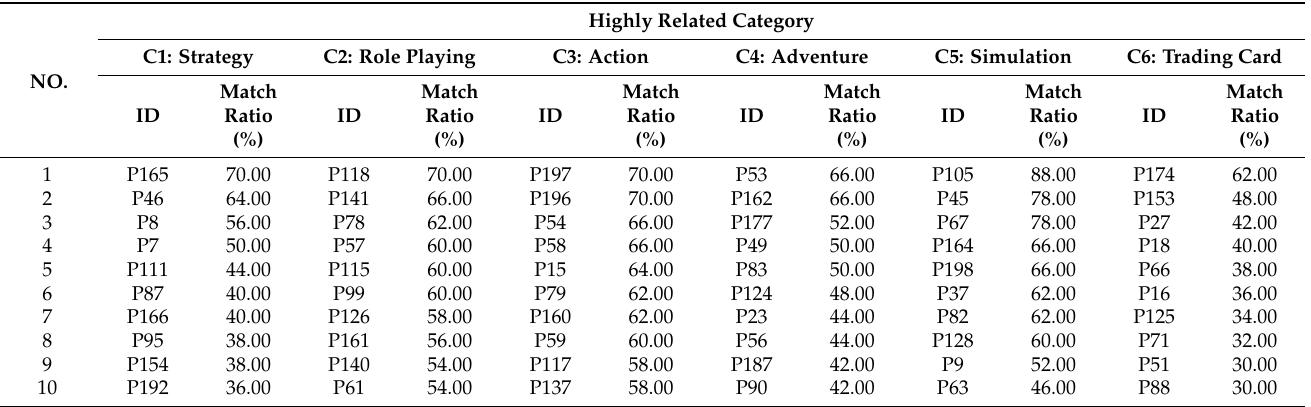
Table 4. High match icons in 6 categories after the classification